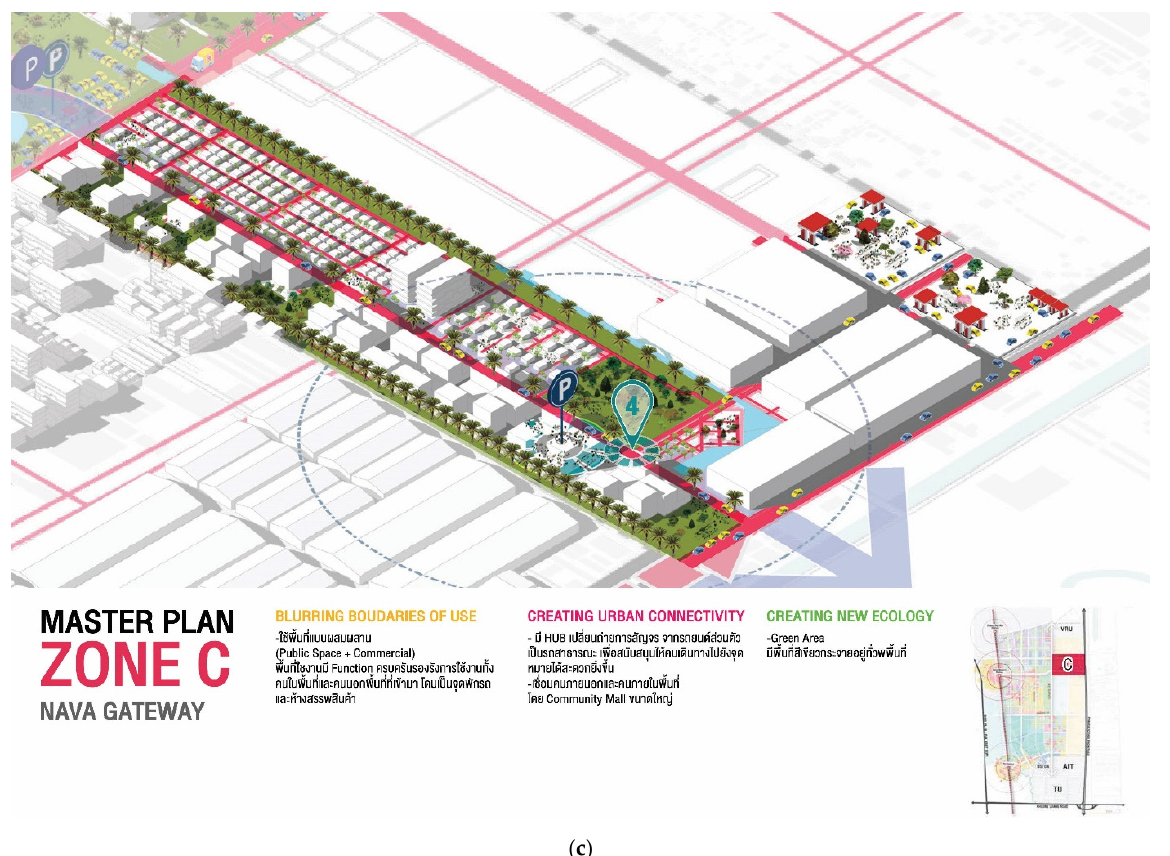
Figure 8. ( a ) Master-plan overview of zone A (from Figure 6), emphasizing development opportuni- ties in the immediate area of the Nava Nakorn BTS station. Graphics credits in Figures 6 and 7